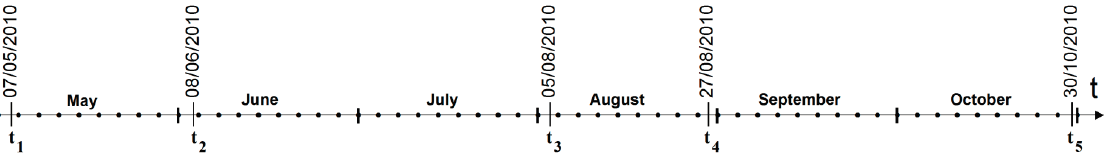
Figure 3. The set of images used included four Landsat ETM+ images (image t 1 , image t 2 , image t 4 , image t 5 ) illustrated in false-color composite (R: NIR, G:Red, B:Green) and one Rapideye image (image t 3 ) in false-color composite (R: NIR, G:Red, B:Green).